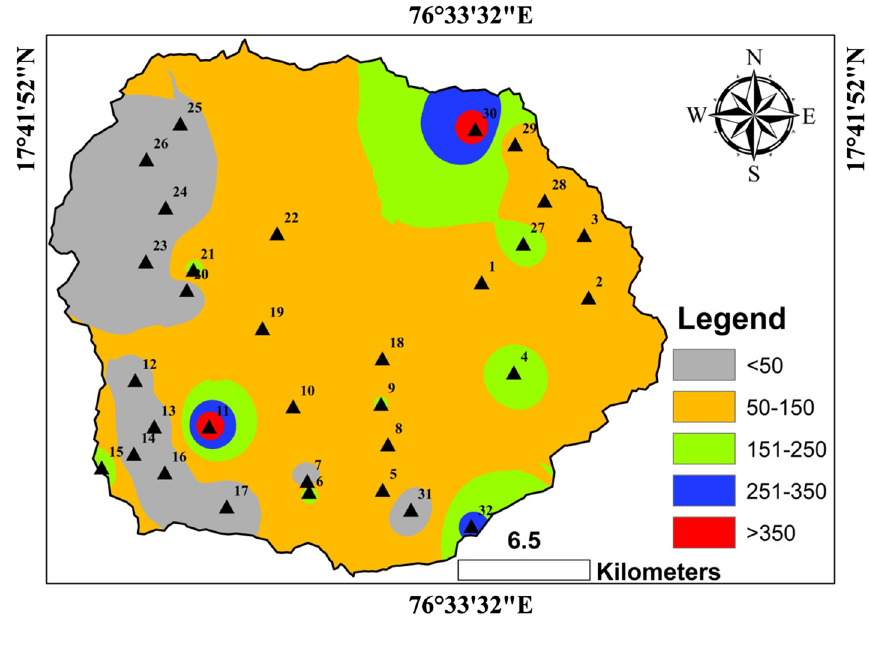
Fig. 31 Geospatial distribution of hardness